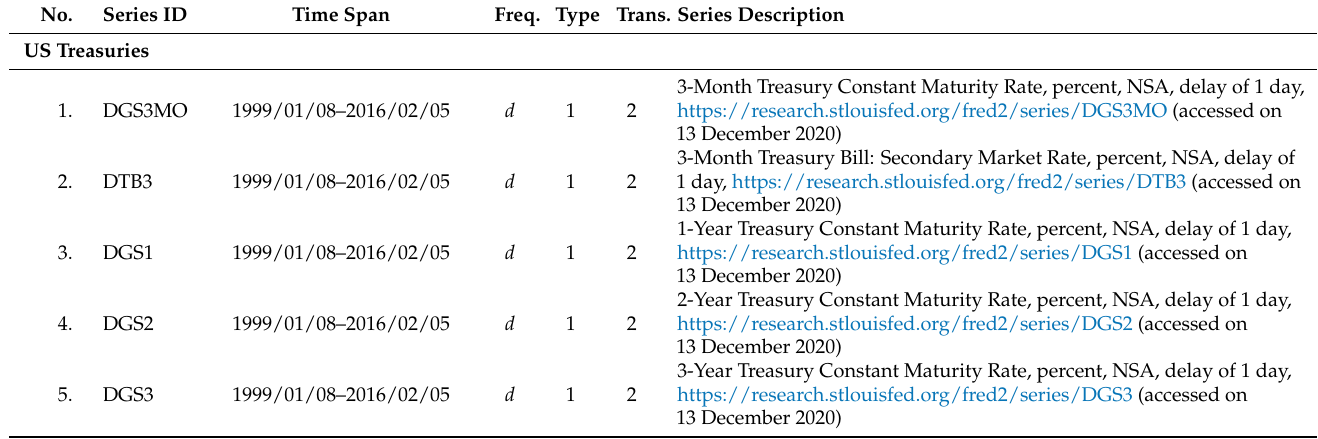
Table A15. Panel data